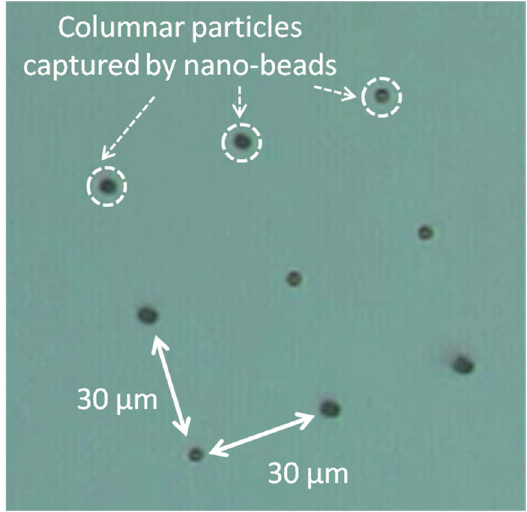
Figure 6. Optical microscope image of columnar particles magnetically captured by nano-sized particles immobilized on the surface of the substrate. Adapted from